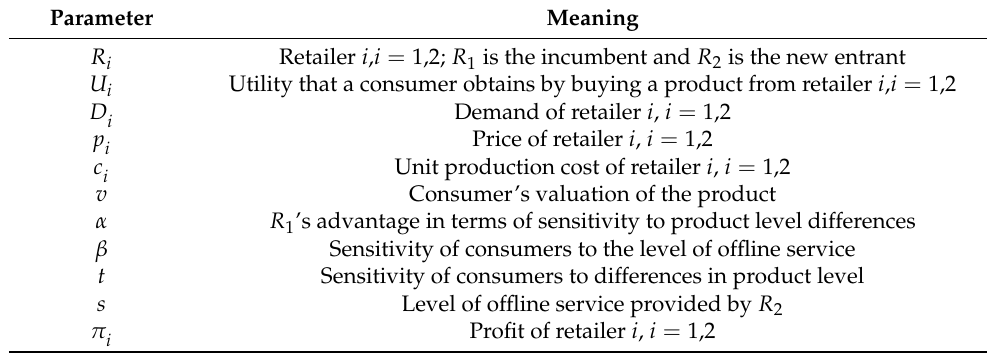
Table 1. Definitions of primary parameters and decision variables.